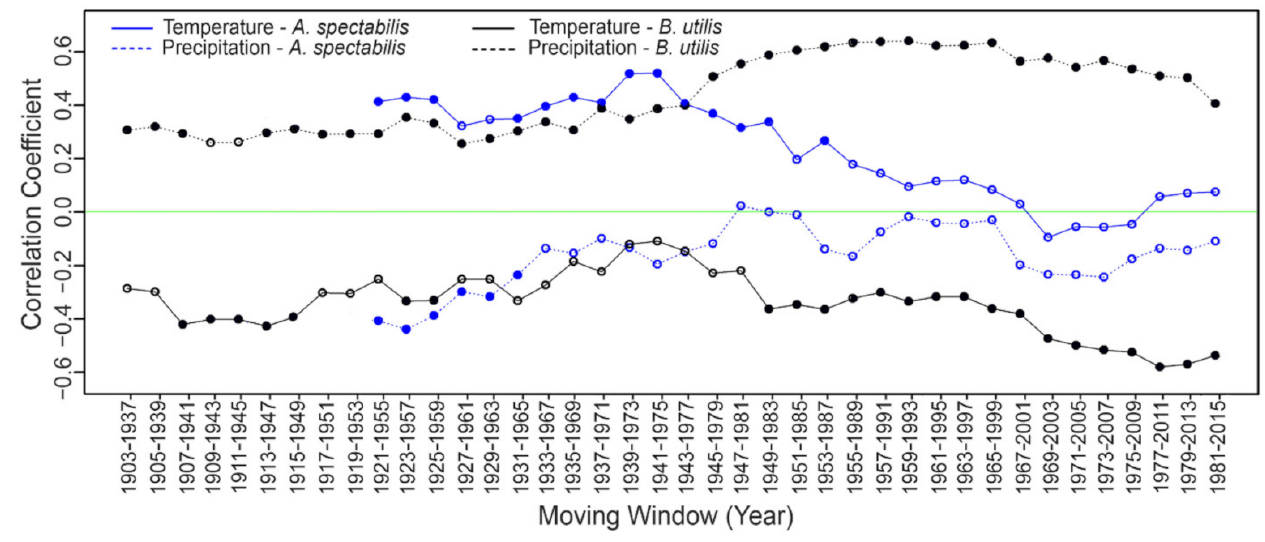
Figure 7. Moving correlation of Abies spectabilis and Betula utilis radial growth with mean spring temperature and precipita- tion sum over time. Solid fill indicates the significance at